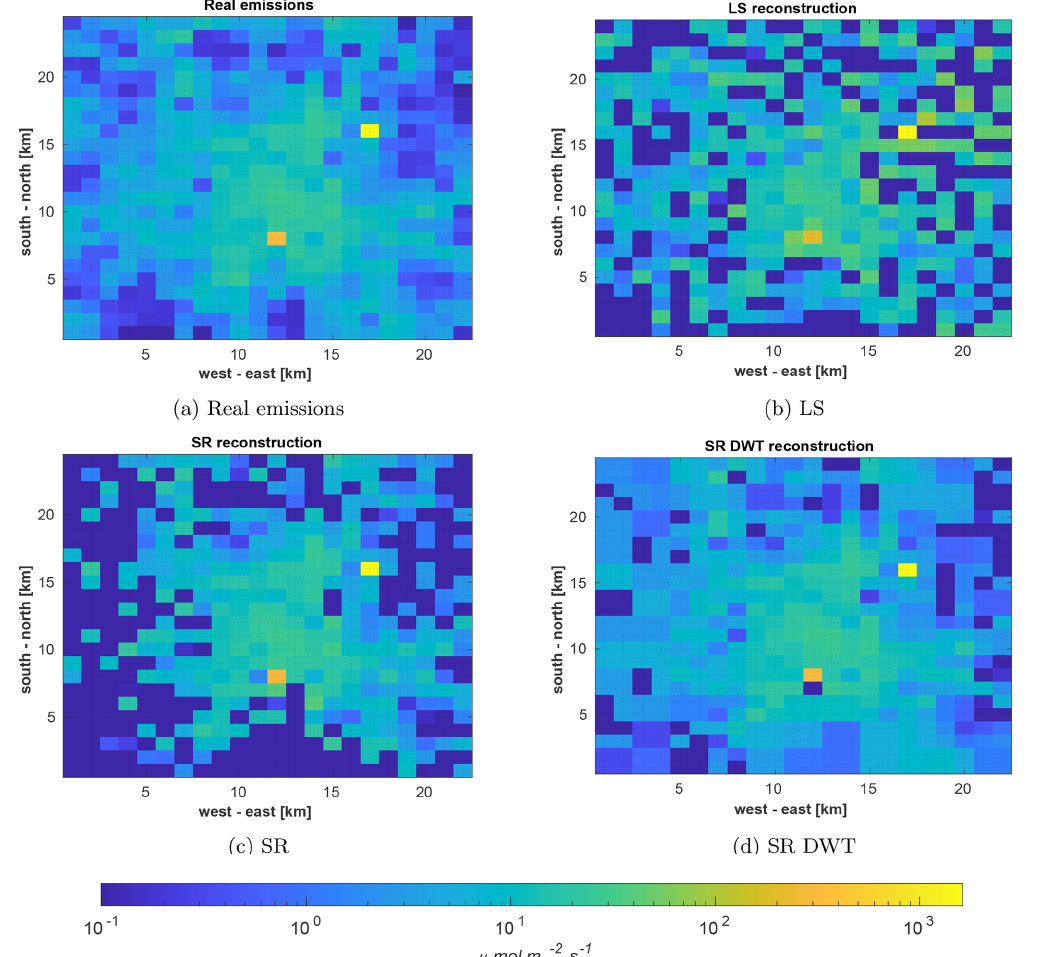
Figure 4. Visualization of the (a) emission inventory of Munich and estimated emission fields of the inventory by using (b) LS, (c) SR, and (d) SR in the wavelet domain. The color scale is logarithmic and given in the unit of µmol ( m 2 s ) − 1 . Negative emissions are colored dark blue and cannot be visually distinguished from low or 0 emitters. The emission inventory does not include negative